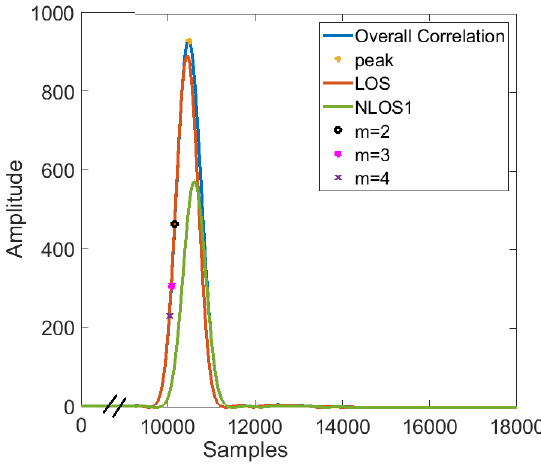
Figure 1. The envelope of correlation for LOS, one NLOS component (NLOS1) and the combined